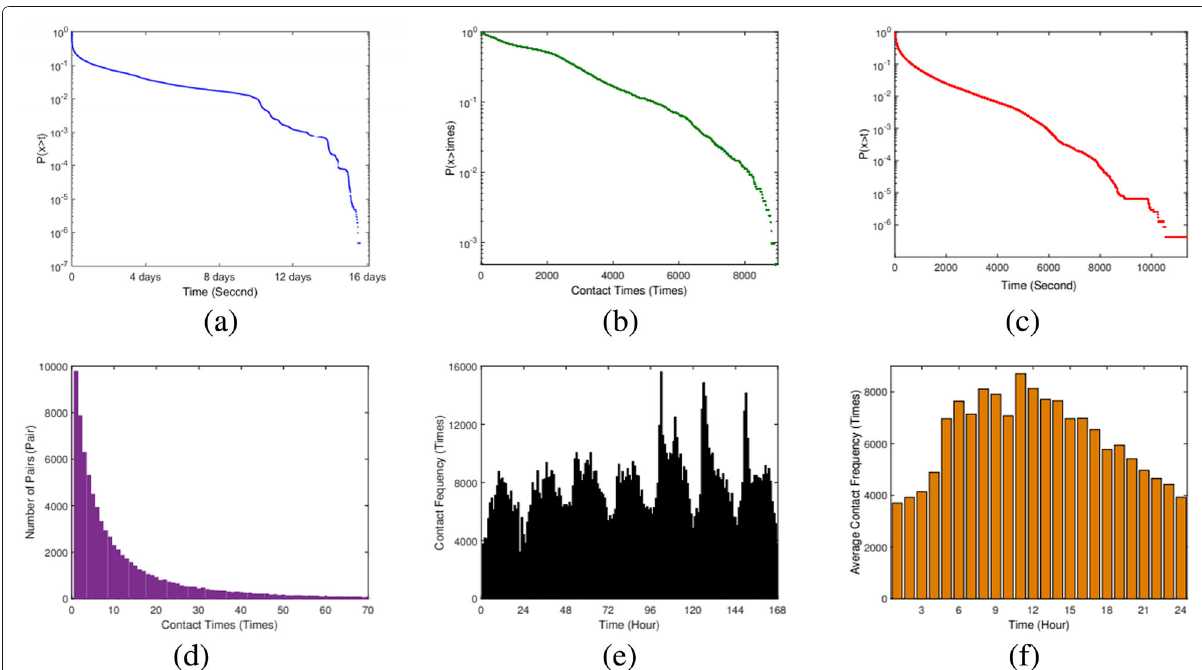
Fig. 7 Contact pattern results ( a ) Inter-contact time distribution ( b ) Vessel contact times distribution ( c ) Vessel sailing alone time distribution ( d ) Contact times distribution of same ( e ) Contact times of each hour(part) ( f ) Average contact times